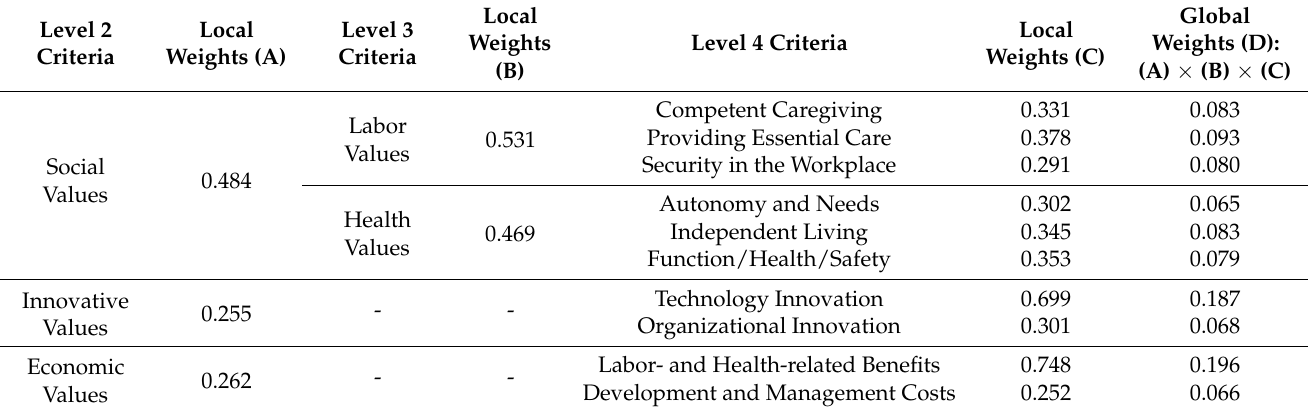
Table 3. Local and global weights of social values of care robots.